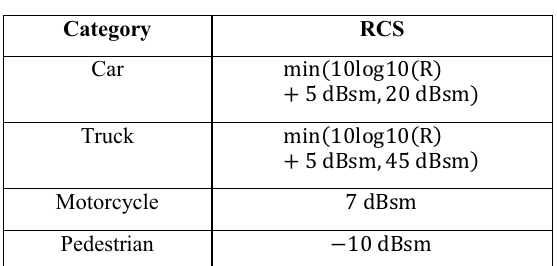
TABLE II. RCS OF TARGETS